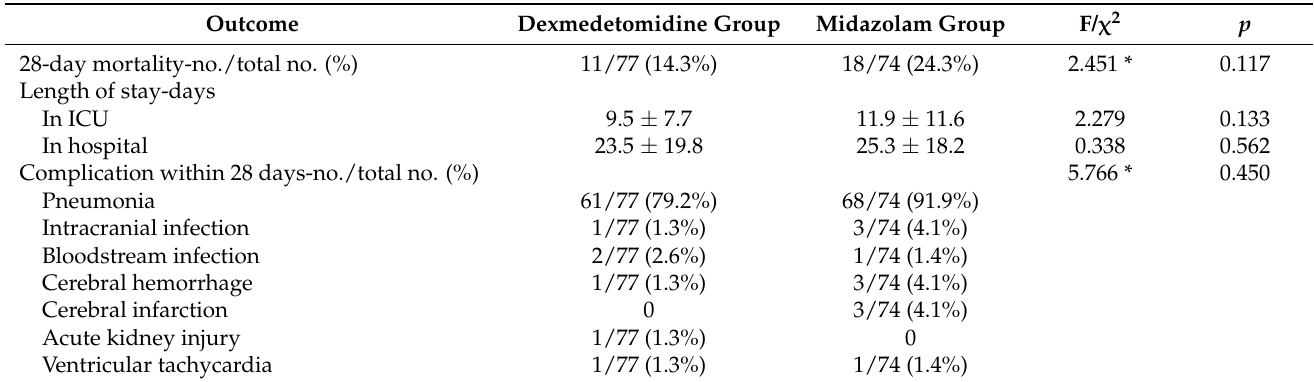
Table 2. Clinical